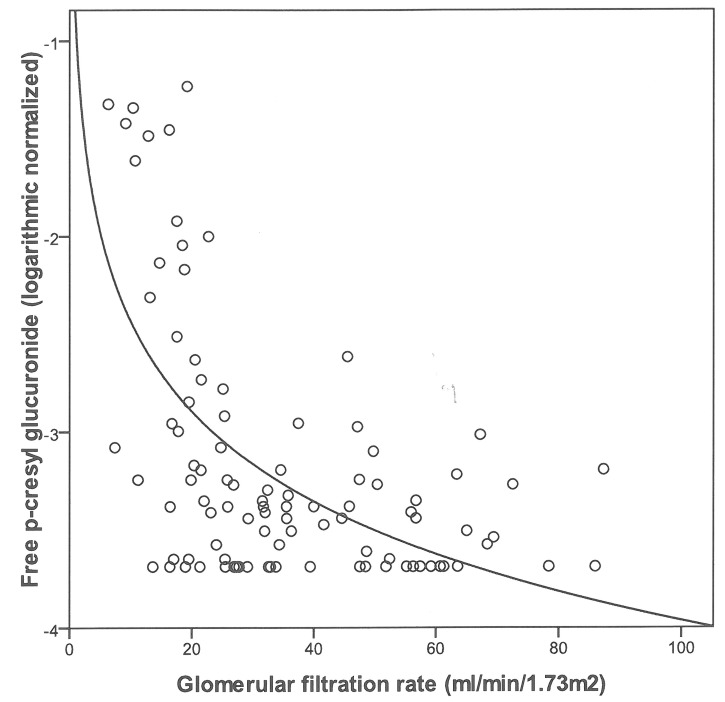
Logarithmic regression curves.The relationship between log-normalized free p-cresylglucuronide serum levels and the estimated glomerular filtration rate for patients at CKD stages 2 to 5; r2 = 0.34, p<0.0001 (n = 96).